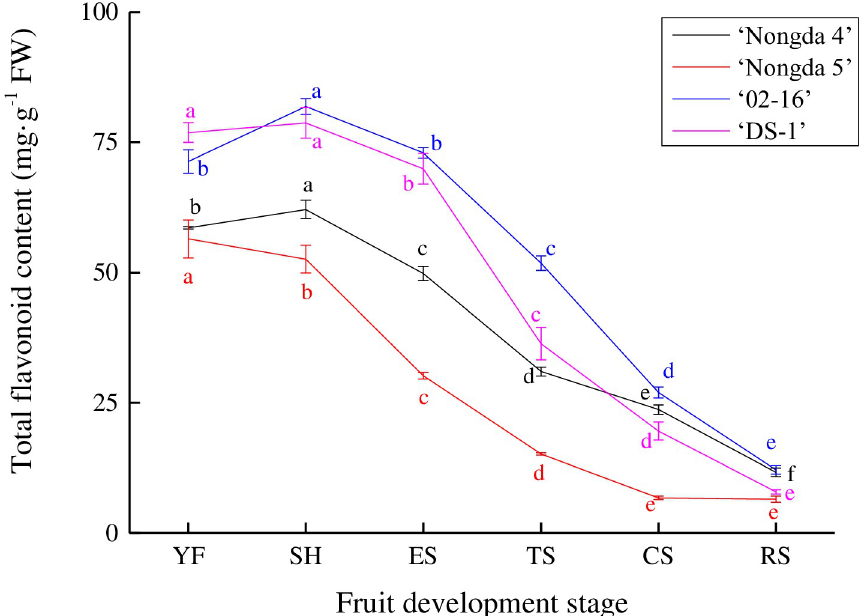
Fig 1. Dynamic change of total flavonoid content in Prunus humilis fruit. Note: The same color letters indicate significance at P < 0.05. FW, Fresh weight; YF, Young fruit stage; SH, Stone hardening stage; ES, Expension stage; TS, Turning stage; CS, Coloring stage; RS, Ripening stage.